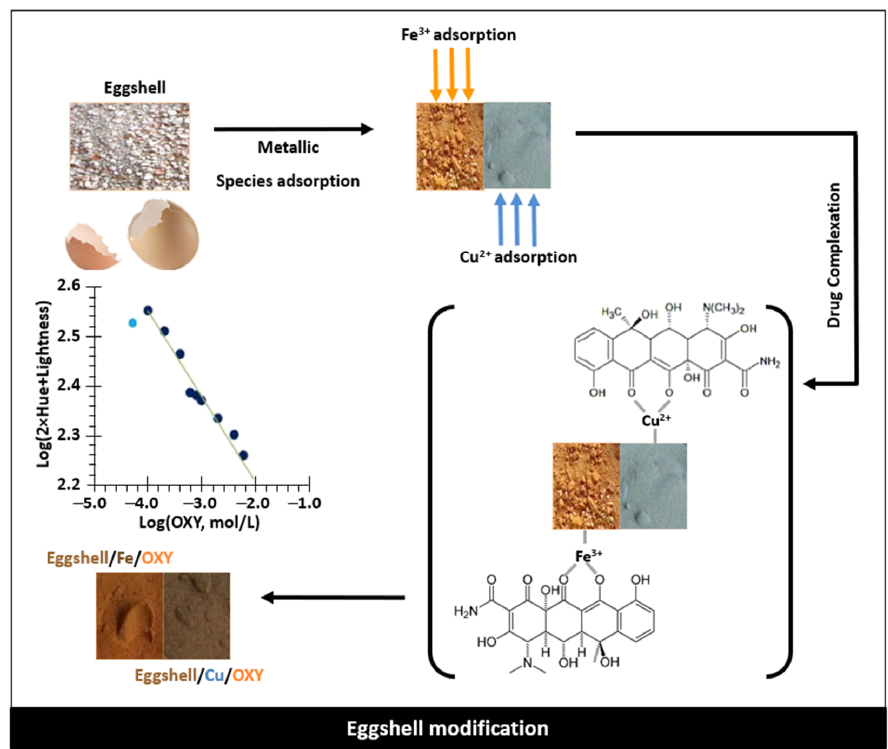
Figure 1. Schematic representation of the eggshell grinding and modification, starting by metal adsorption, which was followed by drug reaction to produce a coloured material that gives a linear trend between the colour coordinates and the log concentration of antibiotic.